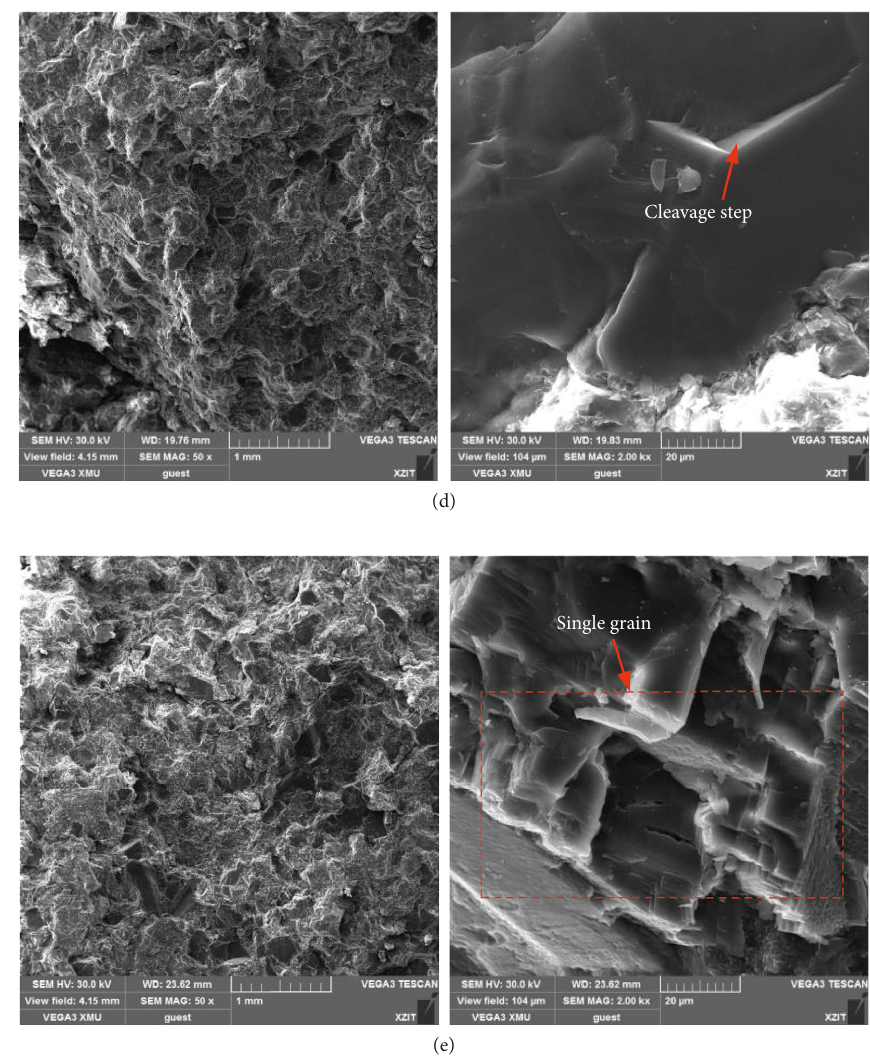
Figure 14: Failure of microstructures in specimens with different water contents: (a) ω � 0.31%; (b) ω � 0.54%; (c) ω � 0.71%; (d) ω � 0.93%; (e) ω �